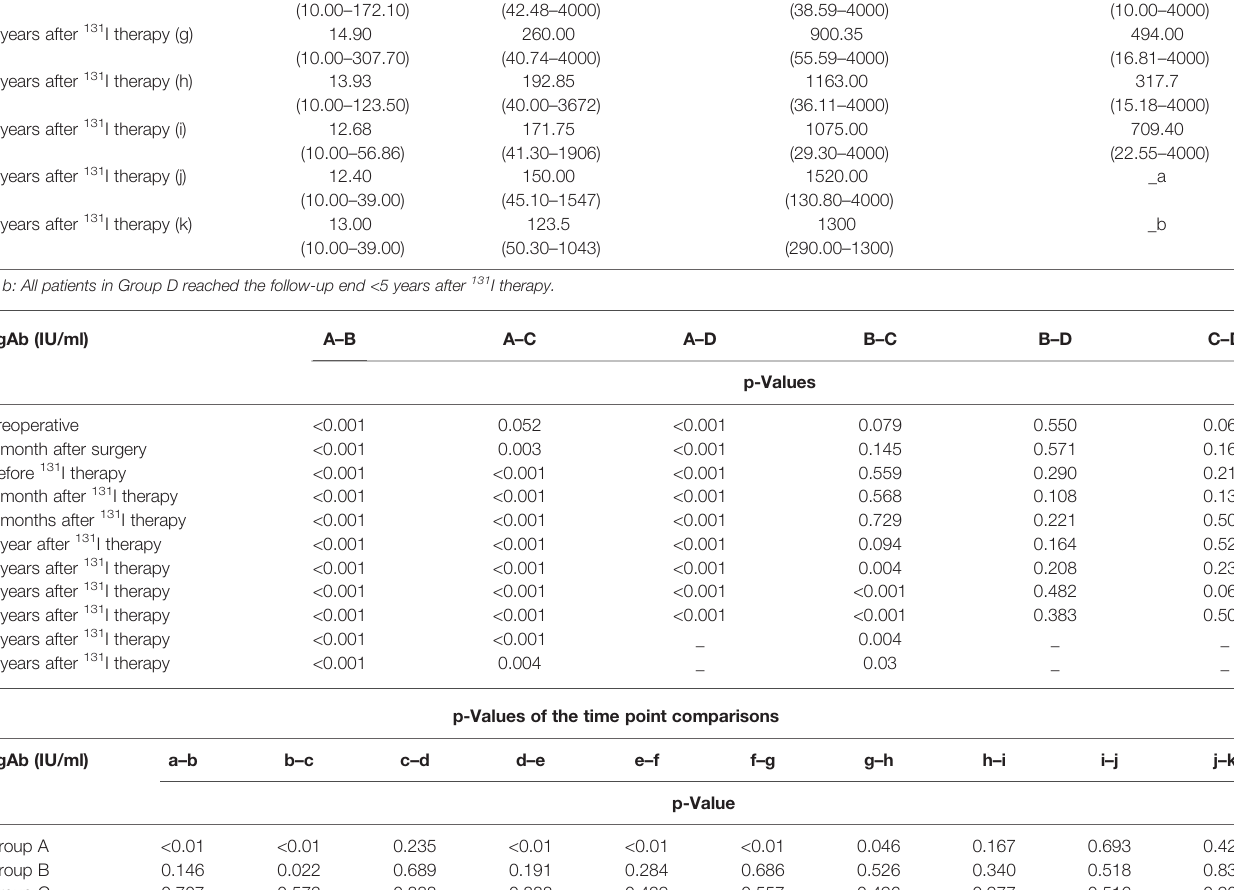
TABLE 2 | Levels of TgAb at every time point in the 4 groups. TgAb (IU/ml), median (range)